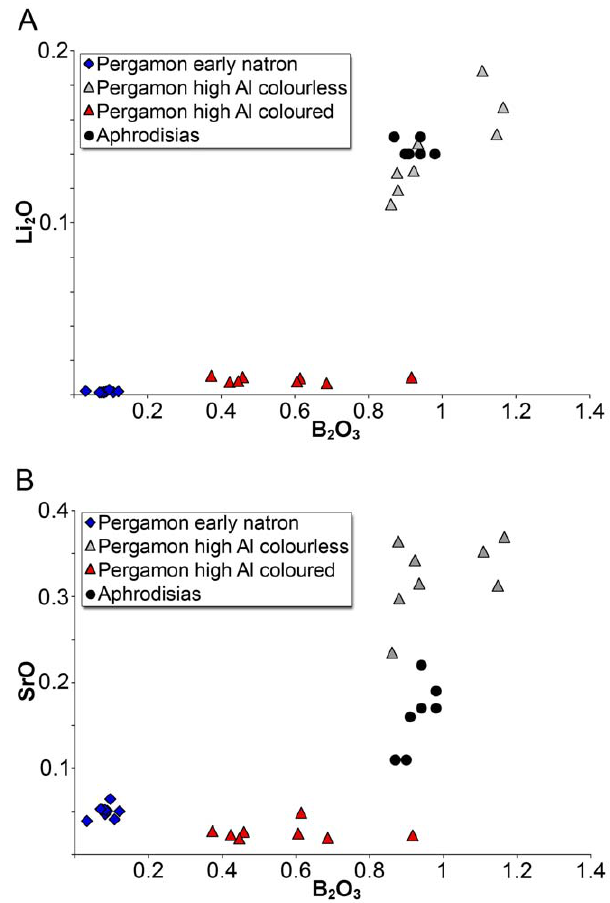
Figure 4. Trace element concentrations of the high alumina glasses from Pergamon. (A) The comparison of lithium and boron concentrations differentiates the colourless and pinkish high alumina glasses (light grey triangles), from the coloured high alumina glasses (red triangles) and the natron-type glasses from Pergamon (blue diamonds). The boron and lithium contents are positively correlated in the colourless and pinkish high alumina Pergamon samples, and are similar to the concentration in samples from Aphrodisias (black circles; [36,54]. (B) The strontium levels further separate the colourless and pinkish (light grey triangles) and the coloured high alumina glasses (red triangles) from Pergamon. The fragments from Aphrodisias (black circles) show intermediate strontium levels. The early natron-type glasses from Pergamon (blue diamonds) are plotted for comparison.